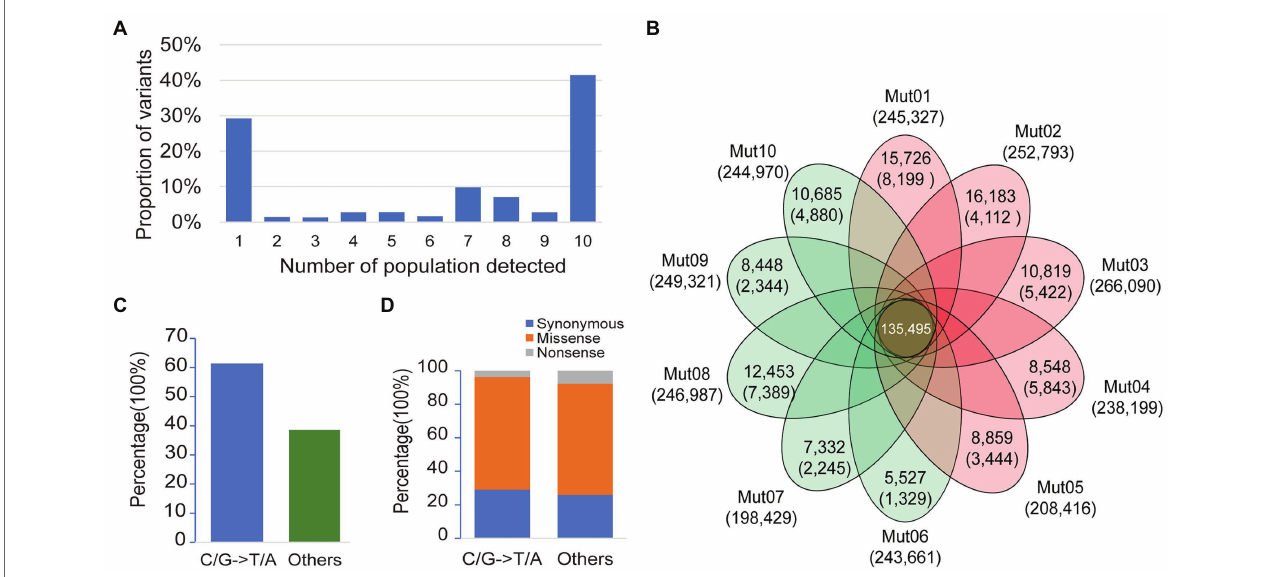
FIGURE 2 | Patterns of genetic variation among 10 populations. (A) The allele frequency spectrum of 340,546 variants detected from 10 bulk pairs highlights that a high proportion of the genetic variants are population specific (present in only one population) or widespread (present in all 10 populations). (B) The Venn plot of the number of high-quality variants (HQ variants) detected in each population. The total number of HQ variants within each population is listed below the population name. The number of HQ variants shared by all populations is in the center. Numbers without the parenthesis in the non-overlapping portions of each oval indicate the number of HQ variants unique to each population, while the numbers in the parenthesis represent the number of ethyl methanesulfonate- (EMS-) induced variants in each population. (C) Proportion of canonical and noncanonical EMS-induced mutants in all populations. (D) Proportion of mutagenic variants in a coding region with different functional